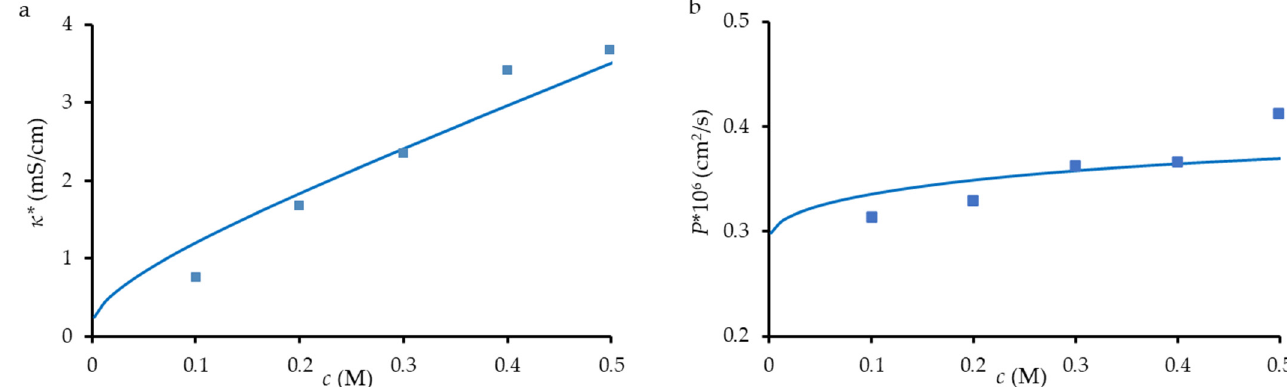
Figure 5. Experimental (dots) and simulated (lines) electrical conductivity ( a ) and diffusion permeability ( b ) of TEM#811 as functions of NaCl concentration. Simulations were made using the parameters presented in Table 2.